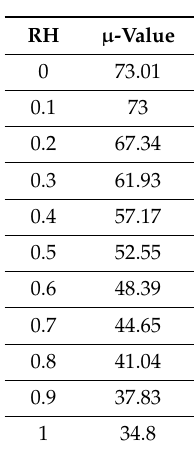
Table A7. Water vapor di ff usion resistance factor.